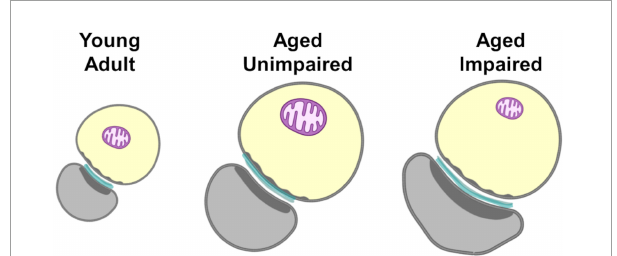
FIGURE7 Summary of ultrastructural changes in marmoset dlPFC layer III as a function of age and cognitive status. Synapses (cyan) were larger in aged animals compared to young, and this was exacerbated in the aged animal with cognitive impairment. Presynaptic boutons (yellow) were also larger in aged animals compared to young, but did not vary in size as a function of cognitive status. While the sizes of presynaptic boutons were highly correlated with the sizes of synapses in the young adult and aged unimpaired animals, this correlation was significantly weaker in the aged impaired marmoset. There were no differences in mitochondria (purple) prevalence, size, or morphology between any of the animals. The correlation between bouton size and mitochondrial size, which was strong in the young adult and aged unimpaired marmosets was entirely absent in the aged impaired marmoset.